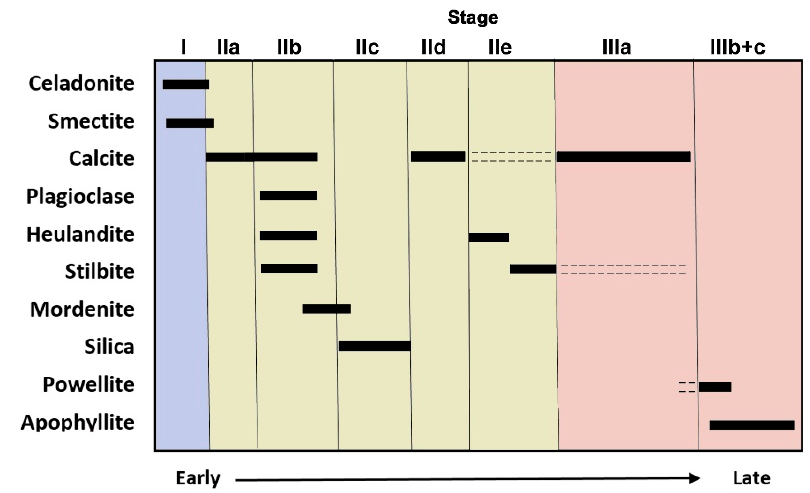
Figure 17. General mineralization sequence of the secondary minerals in the large cavities of the flow core zone in Savda.